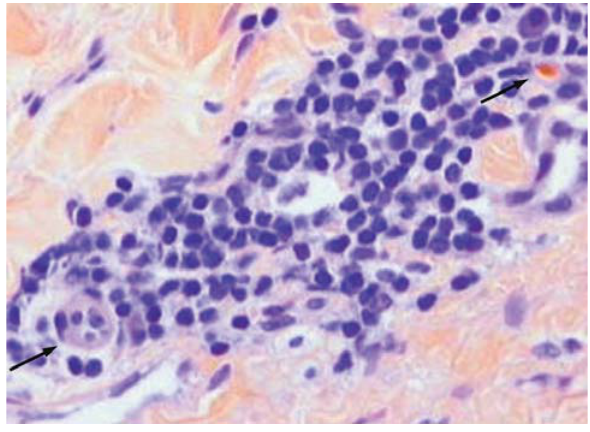
Fig. 2 - Estudo histopatológico da camada média da aorta. Camada média da aorta com infiltrado inflamatório com plasmócitos (seta superior direita) e linfócitos com arteríola com reatividade endotelial (seta inferior esquerda). [Hematoxilina & Eosina,